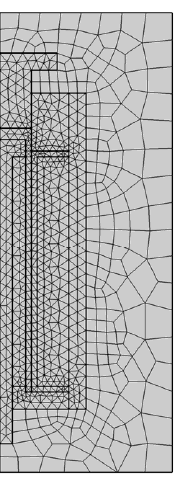
Figure 4. Schematic diagram of GMA meshing.